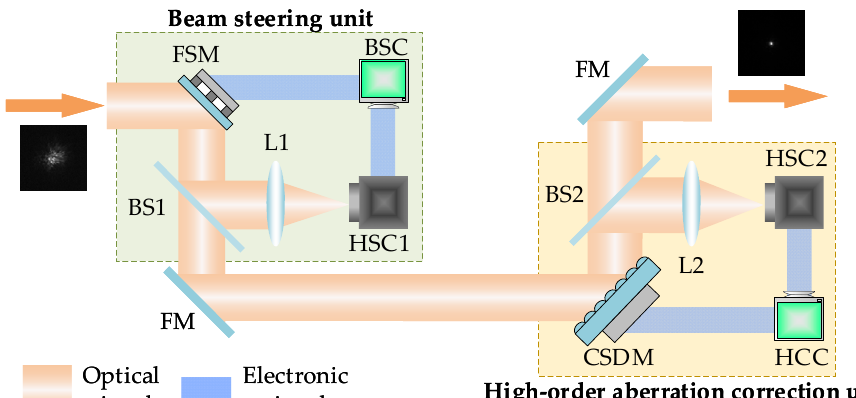
Figure 2. Schematic of SLAO system.